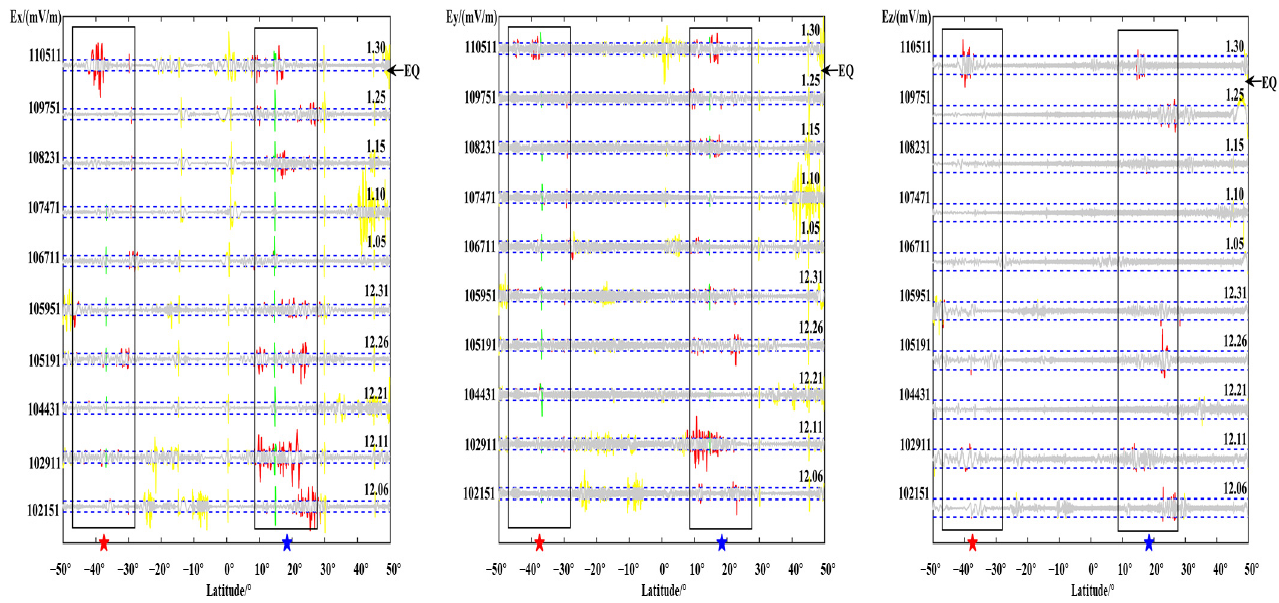
Figure 7. Orbit 109,751 and its revisited Figure 7. Orbit 109 , 751 and its revisited tracks.